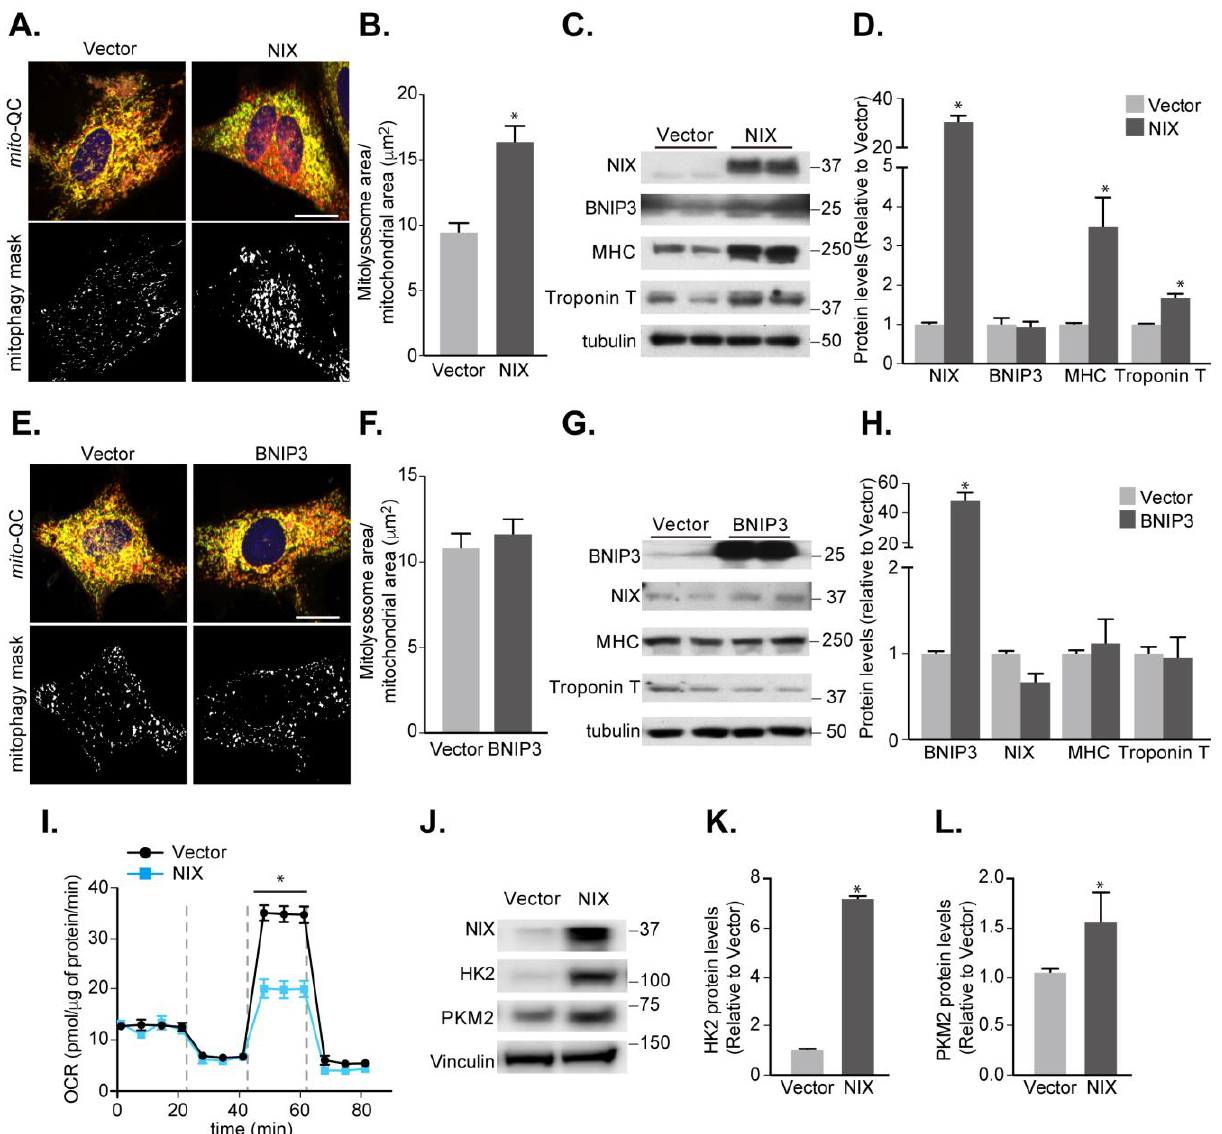
FIGURE 7: Increasing NIX-dependent mitophagy promotes cardiomyocyte differentiation. (A) Representative images from mito -QC H9c2 vector control cells or cells overexpressing NIX cultured following 7 days differentiation. Mitophagy mask represented as the mCherry/GFP ratio intensity above the mean of mCherry intensity. (B) Quantitation from (A) of total mitolysosome area per mitochondrial content as indicated. (C) Representative immunoblot of NIX, BNIP3, MHC and cardiac Troponin T protein levels from 7 days differentiated H9c2 cells stably overexpressing NIX. (D) Quantitation of data from (C). (E) Representative images from mito -QC H9c2 cells overexpressing vector or BNIP3 cultured in differentiation medium for 7 days. (F) Quantitation from (E) of total mitolysosome area per mitochondrial content as indi- cated. (G) Representative immunoblot of NIX, BNIP3, MHC and cardiac Troponin T protein levels from 7 days differentiated H9c2 cells stably overexpressing BNIP3. (H) Quantitation of data from (G). (I) Oxygen consumption rate (OCR) was measured after H9c2 cells stably overex- pressing vector or NIX following 7 days differentiation. (J) Immunoblot of HK2 and Pyruvate kinase (PKM2) from H9c2 cells stably overex- pressing vector or NIX cultured in differentiation medium for 7 days. Quanitation of HK2 (K) and PKM2 (L) is shown. Scale bar, 20 μm. All quantitative data are mean ± SEM from 3 independent experiments. * P <